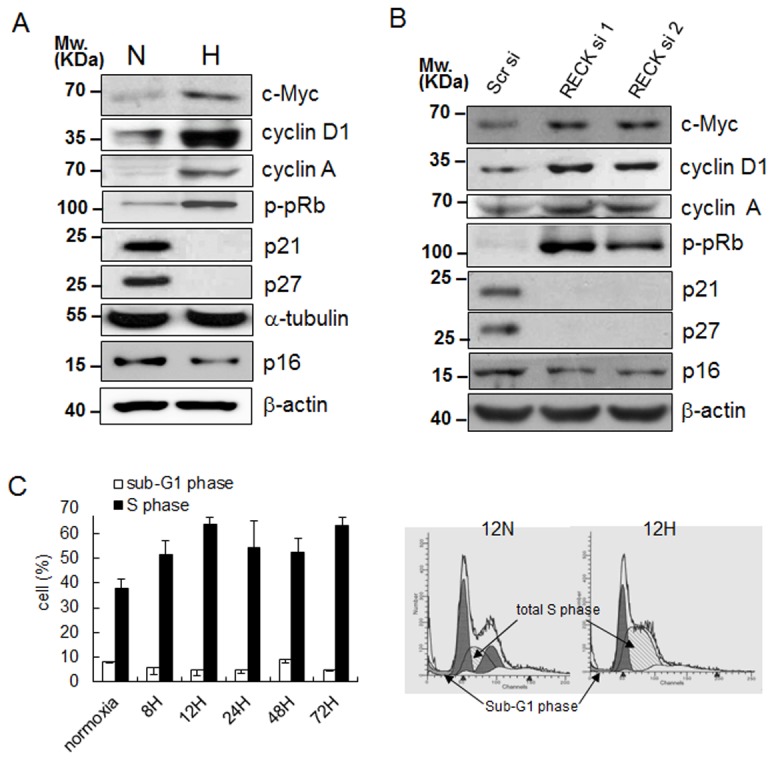
Hypoxia and silencing of RECK increased cell cycle progression.(A) Western blot analysis with anti-c-Myc, cyclin D1, cyclin A, phosphorylated Rb (p-pRb), p21, p27, and p16 were performed under normoxic (N) and hypoxic (H) conditions after 24 h of exposure. (B) After transfecting scrambled siRNA (Scr) and two kinds of siRECK (si1 and si2), levels of cell cycle proteins in cell lysates were determined by Western blotting. (C) Cell cycle analysis by FACS after PI staining. The diagram shows the diploid S and sub-G1 phase HEK293 cells under hypoxic conditions up to 72 h after staining and those of normoxic controls (cont). Right cytograms show the proportion of cell populations in each cell cycle stage in 12 h normoxia (12N) and hypoxia (12H). All experiments were performed at least in duplicate.